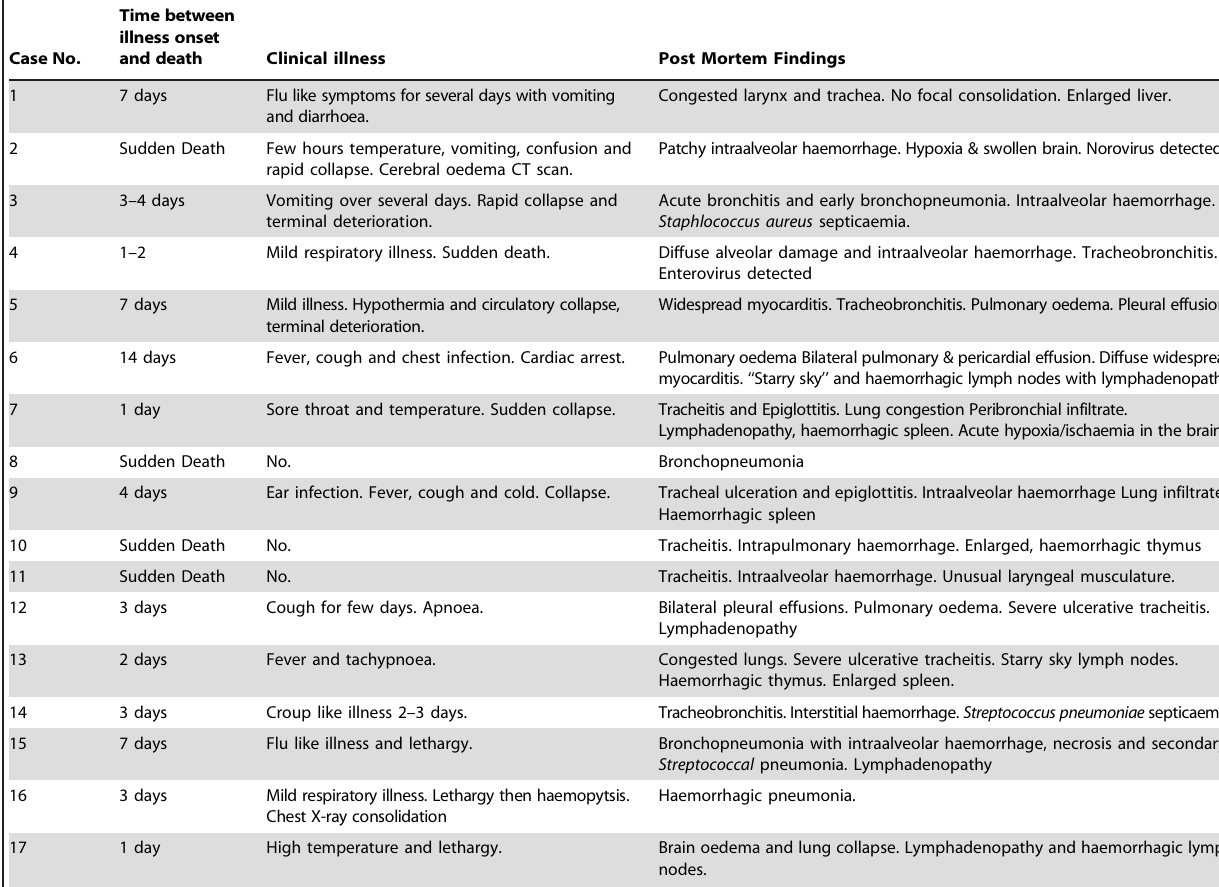
Table 1. Summary of fatal paediatric cases of influenza H3N2 from 2003–04.